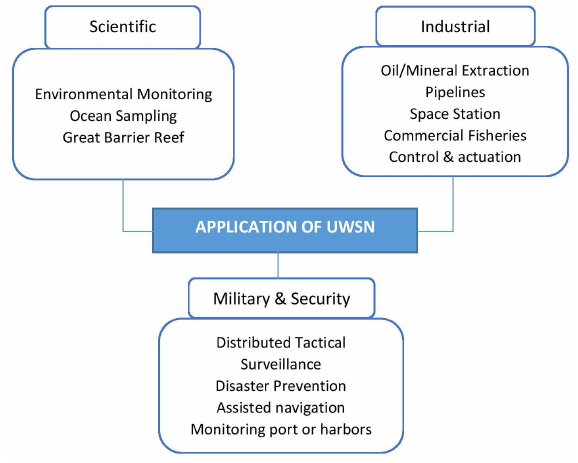
Figure 8. Applications of